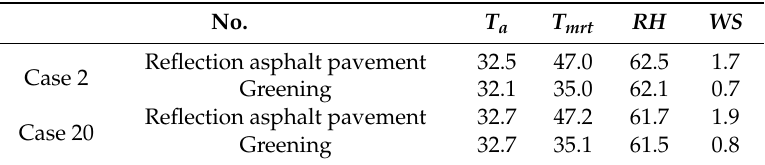
Table 10. ENVI-met results of simulations applying greening and reflective asphalt pavement (meteorological